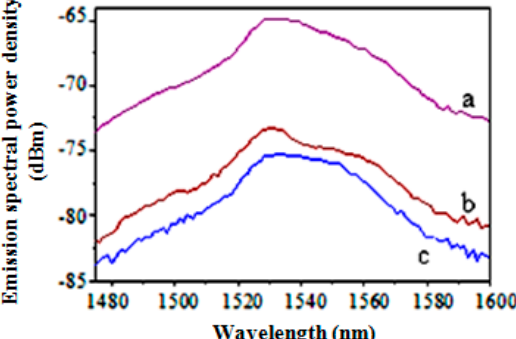
Figure 21. The fluorescence spectra of the three EDFs: (a) A1, (b) A3, and (c) A2 under pump power of 25 mW.